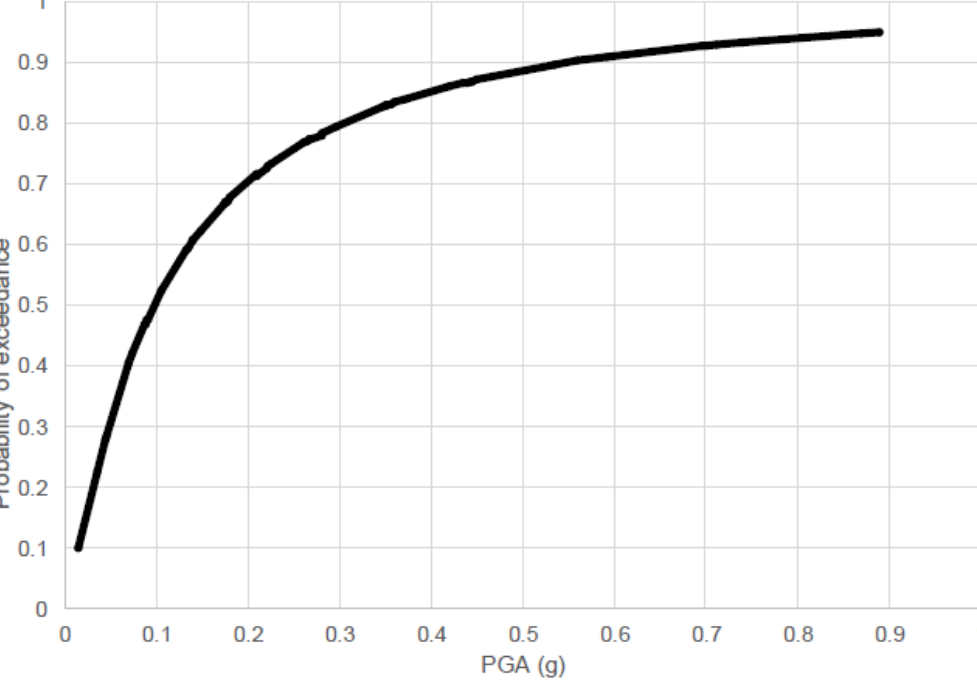
Figure 11. Analytical fragility curve for serviceability level SLS1 (1/25).